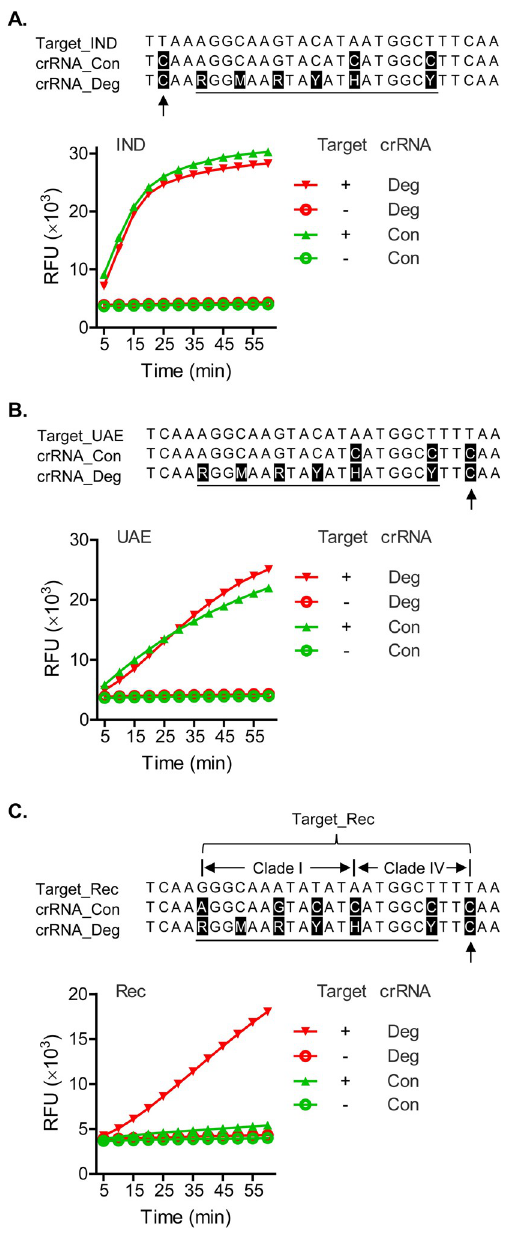
Fig 4. The degenerate sequence-based CRISPR diagnostic is capable of detecting emerging CCHFV variants with new and more complex mutations. Chemically synthesized CCHFV RNA targets were tested for detection at 1 cp/ μ l by the degenerate sequence-based CRISPR set, using crRNA_669–696 (crRNA_Deg), as in Fig 3. A constant sequence- based crRNA, derived from the Hoti strain, crRNA_669–696_5.Hoti (crRNA_Con), was compared to the degenerate sequence-based crRNA in the same context. The targeted CCHFV variants were isolates from India (IND, 2018) and United Arab Emirates (UAE, 2017) in Panels A and B, respectively, as well as a recombinant (Rec) between Clades I and IV. Sequences of synthetic RNA templates, RT-RPA primers and crRNAs and GenBank accession numbers of CCHFV strains are provided in Table 2. Sequence of the IND, UAE or Rec variant targeted by CRISPR was each aligned with the degenerate and constant spacer sequences of the crRNAs (all as CCHFV sense sequences). Each nucleotide in the crRNA spacers that differs from that in the targeted CCHFV variant is shaded. In crRNA_Deg, the region is underlined where each degenerate nucleotide covers its counterpart in the target sequence, meaning that one of the mixed nucleotide types represented by the degenerate code matches the counterpart nucleotide in the target. Arrow indicates the nucleotide in crRNA_Deg that does not cover/match the counterpart nucleotide in the target. In Panel C, regions in the target sequence with mutations characteristic of Clade I and Clade II are demarcated,